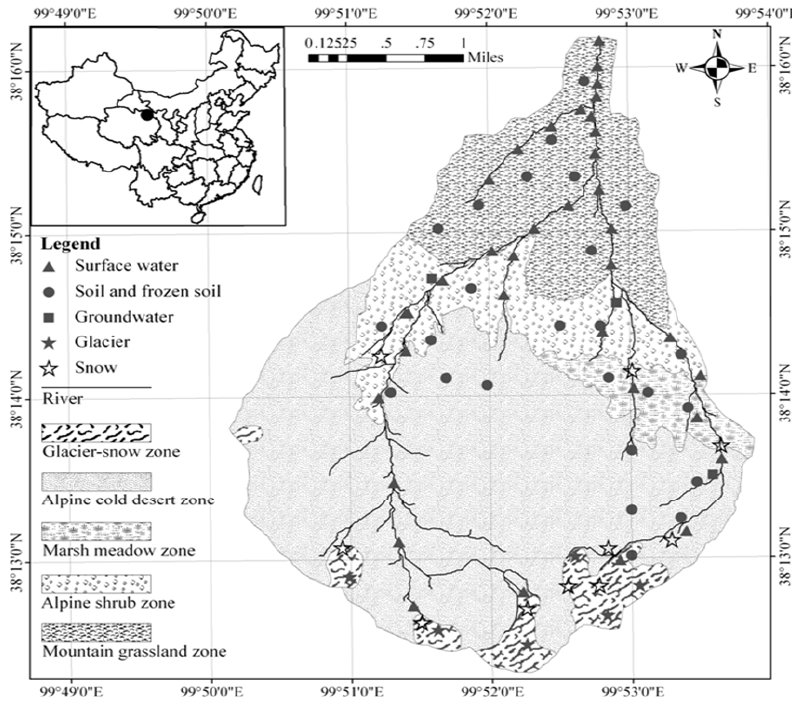
Figure 1. Location of the sampling sites in the study